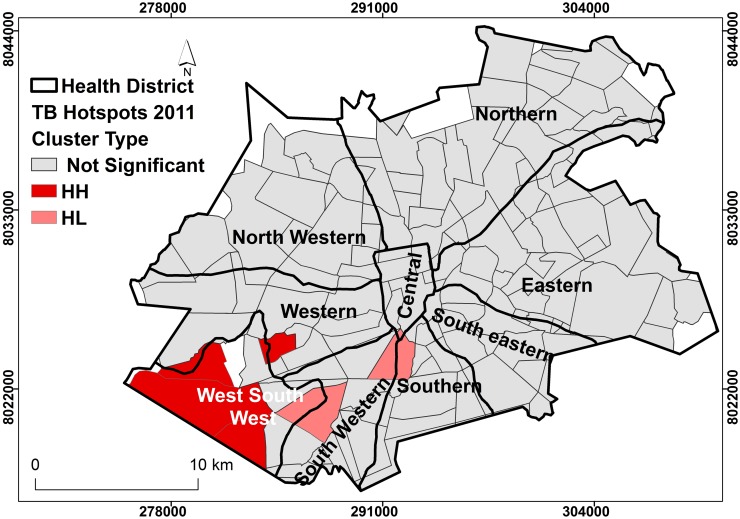
Clustering of TB cases by district, Harare City, 2011.Show the clustering of cases within district. Suburbs with deep shade represent increased occurrence of TB cases that are related to other cases within the same district, (clustering). Districts with clear colour show no clustering at all.